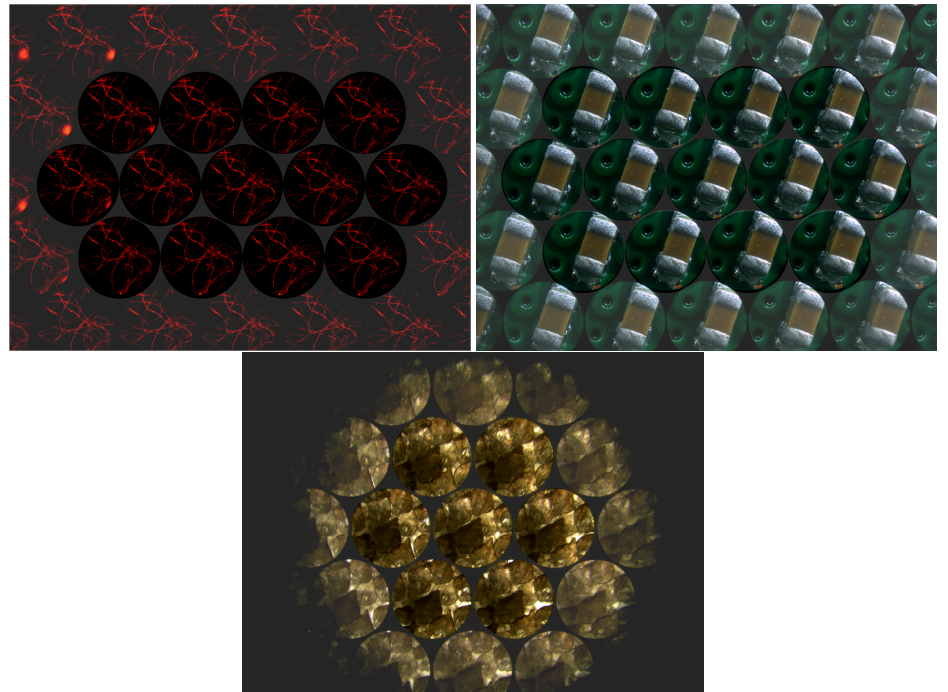
Figure 5. Integral image of the three types of scenes considered: fiber , chip , and shark . In the pictures, we have shaded the non-complete